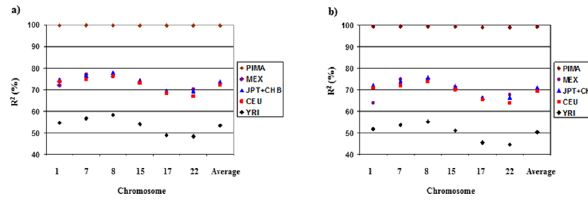
Figure 2. R 2 according to reference population when a) 1% or b) 20% of genotypes were masked.